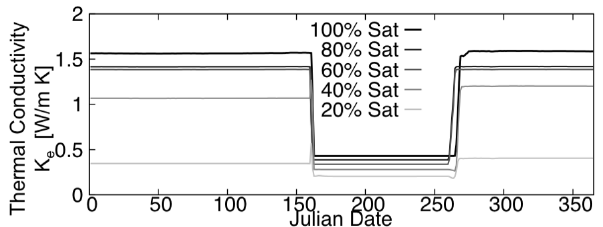
Figure 6. Thermal conductivity of peat throughout a year with dif- ferent surface pressures. Percent liquid saturation is based off of summer time water liquid saturation, which changes during winter due to an increase in ice saturation. The change in thermal conduc- tivity coincides with spring thaw, approximately Julian day 160 or early June, and fall freeze-up near Julian day 265 or late September.